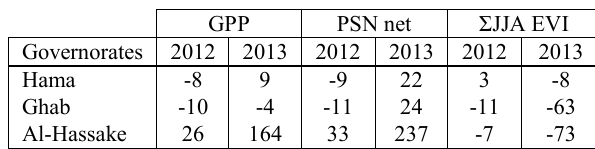
Table 1- Deviation of predicted total summer yield